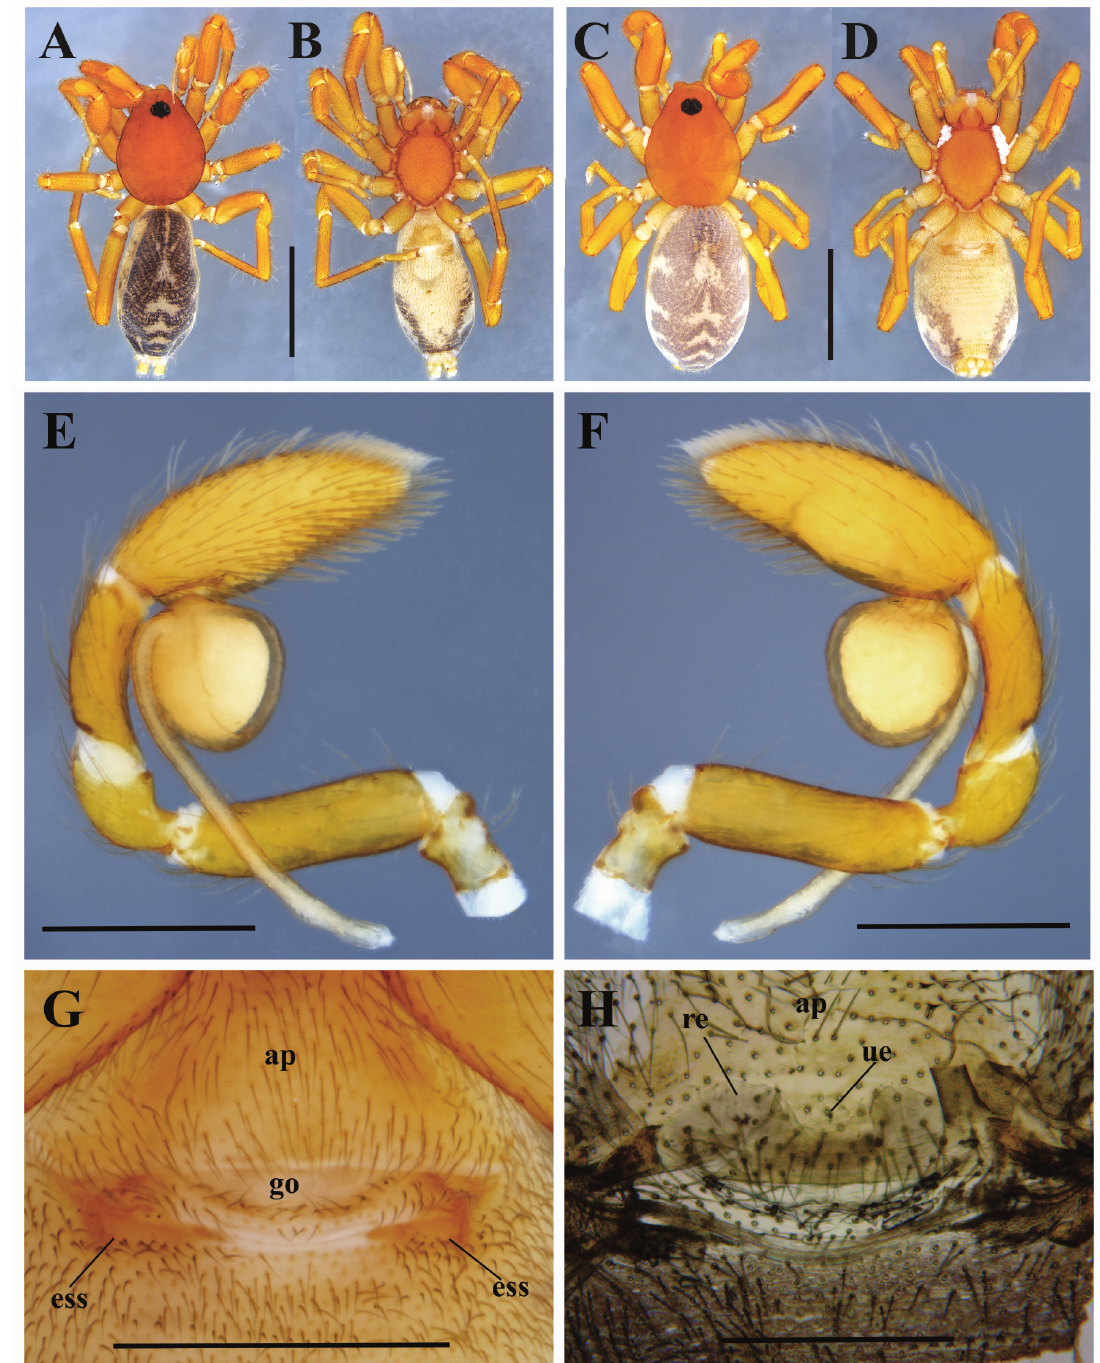
Fig. 1. Medionops blades Sánchez-Ruiz & Brescovit, 2017. A–B, E–F . Male, Boyacá population (IAvH-I 3381). C–D, G–H . Female, Boyacá population (IAvH-I 3382). A . Habitus, dorsal view. B . Habitus, ventral view. C . Habitus, dorsal view. D . Habitus, ventral view. E . Left palp, retrolateral view. F . Left palp, prolateral view. G . External genitalia, ventral view. H . Internal genitalia, dorsal view. Scale bars: A–D = 1.5 mm; E–F = 0.7 mm; G = 0.5 mm; H = 0.2 mm. Abbreviations: ap = anterior plate; ess = external sclerotization around spiracles; go = genital opening; re = receptaculum; ue = uterus